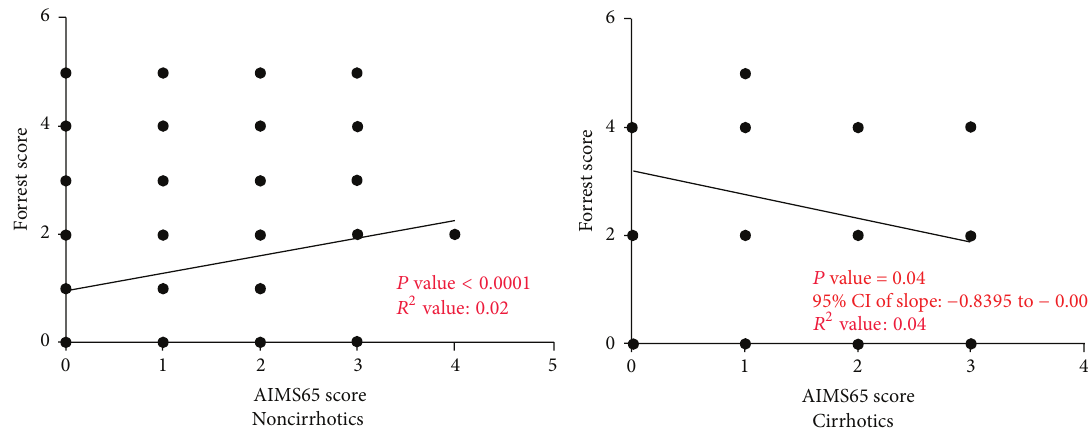
Figure 6: Statistically significant direct correlation was found between weighted Forrest scores and AIMS65 scores in noncirrhotic patients. Statistically significant inverse correlation was found between weighted Forrest scores and AIMS65 scores in cirrhotic